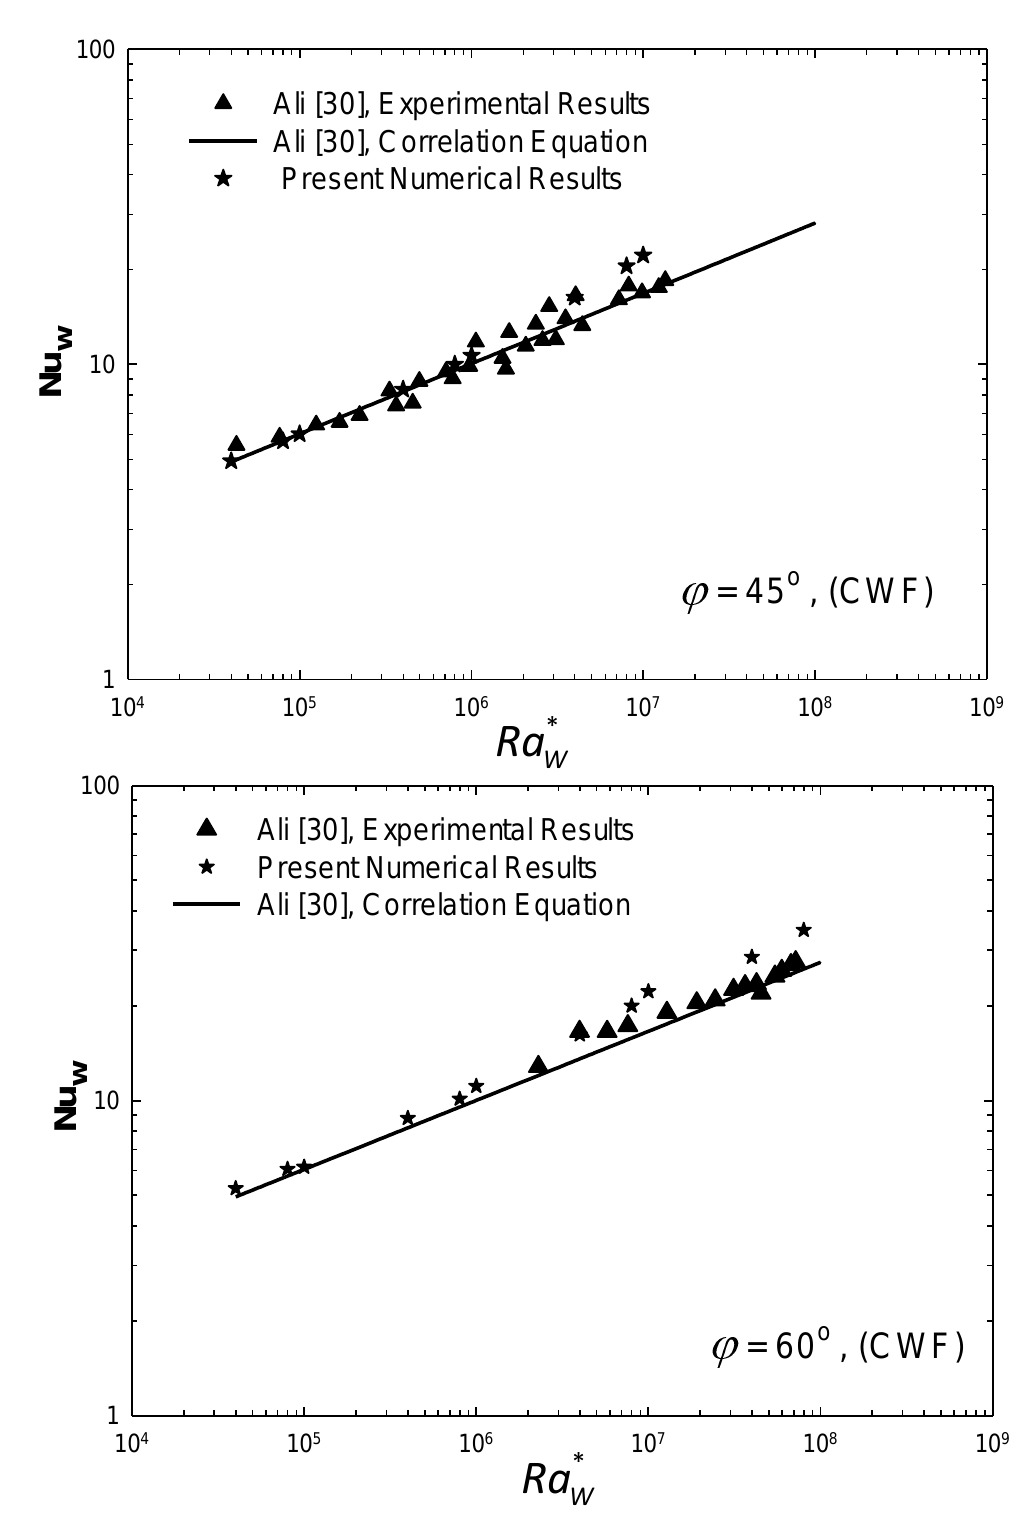
Figure 4. Numerical results of the mean Nusselt number, compared with values obtained from the correlation equations, and with experimental results obtained by Ali [30] for a square cylinder with width ratio W = 0.08 and inclination angles of φ = 60 ° (30 ° from the horizontal) φ = 45 ° for various values of the heat flux Rayleigh number based on W .